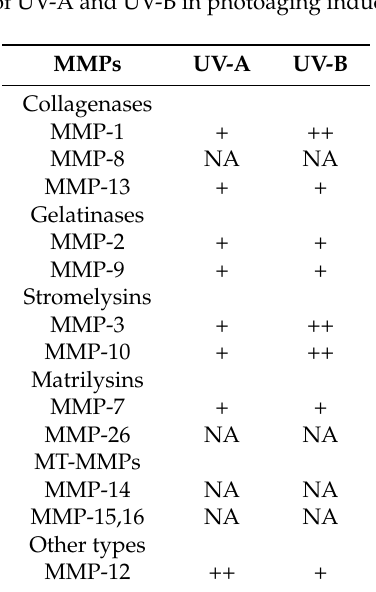
Table 2. Role of UV-A and UV-B in photoaging induced by